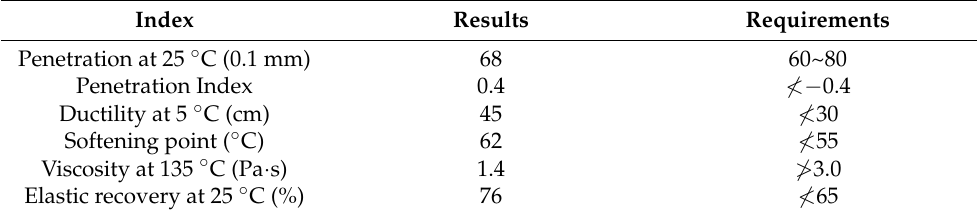
Table 2. Properties of SBS asphalt.